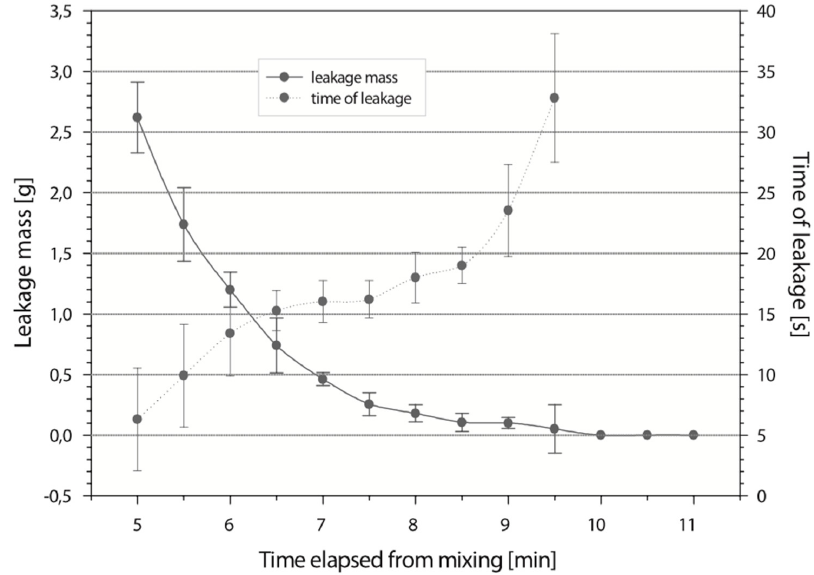
Figure 1. Depiction of leaked cement mass and time when leakage occurred with elapsed time. Adapted from [21], with permission from © 2006 Wolters Kluwer Health, Inc..